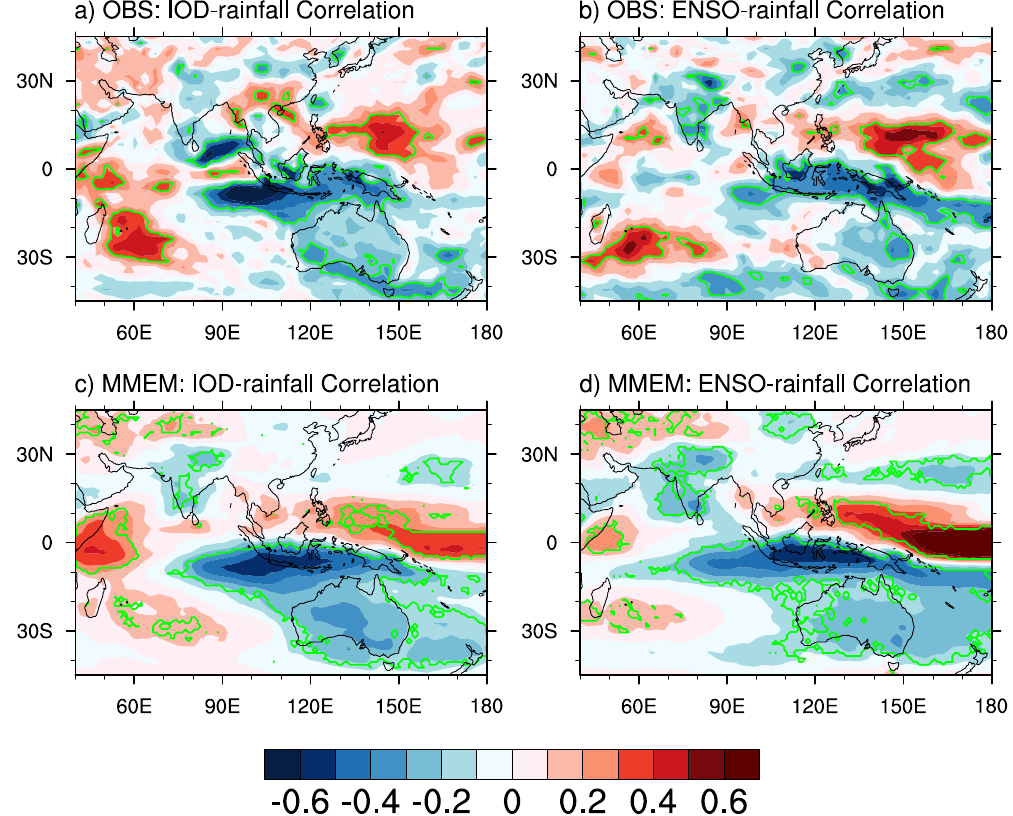
Figure 1. Present-day rainfall’s correlations with ENSO and IOD. ( a ) and ( b ), Observed rainfall correlation with the IOD and ENSO, respectively. ( c ) and ( d ), The same as ( a ) and ( b ), but from the multi-model ensemble mean (MMEM). Areas within the green contours in ( a ) and ( b ) represent regions where the correlation is statistically significant above the 95% confidence level. The significance is calculated using a two-tailed Student’s t -test. The green contours in ( c ) and ( d ) denote areas where the sign of the correlation is consistent over 80% of CMIP5 models. All maps were generated by NCL version 6.3.0